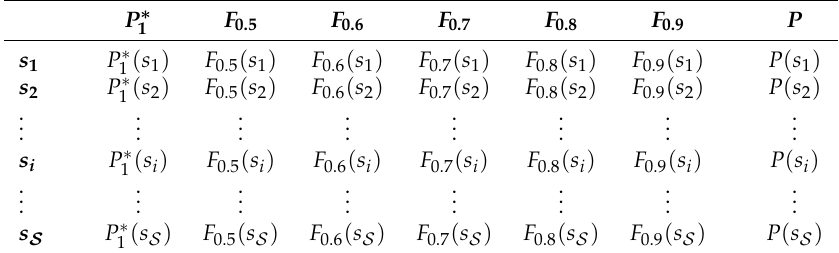
Table 1. Training matrix for the Tabular Learner. P ∗ P ( s i ) represents the true positivity for the i -th tile (used only for the training